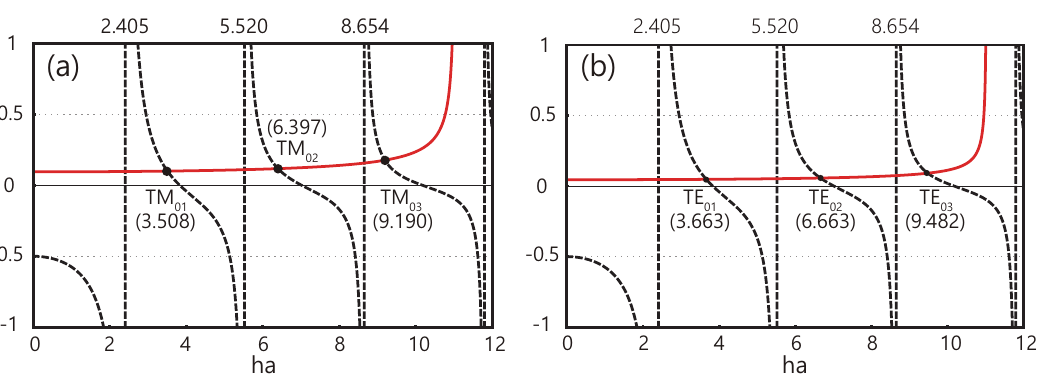
Figure 2. Solutions for the ( a ) TM modes and ( b ) TE modes of Equation (4) at V = 11.03. The right- and left-hand sides of Equation (4) are plotted by the solid-red and black-dashed lines,